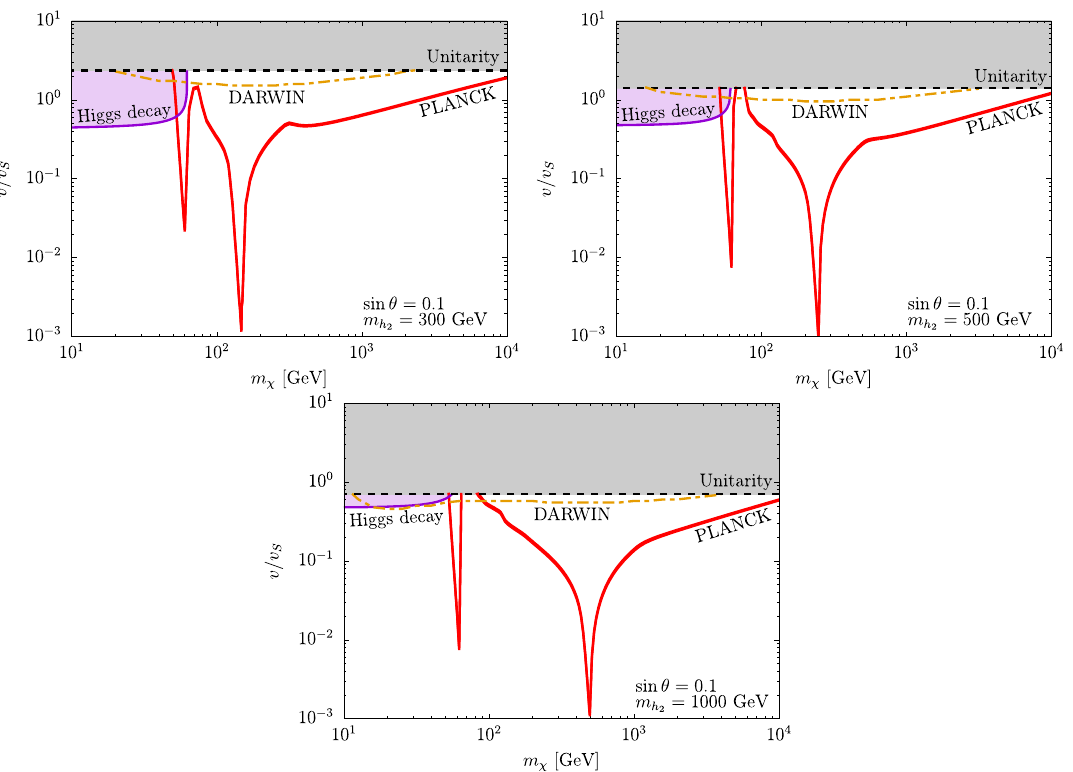
Figure 3 . Exclusion limits on the model from the Higgs decay (purple) and the perturbative unitarity (grey). The red band represents the parameter space which can reproduce the